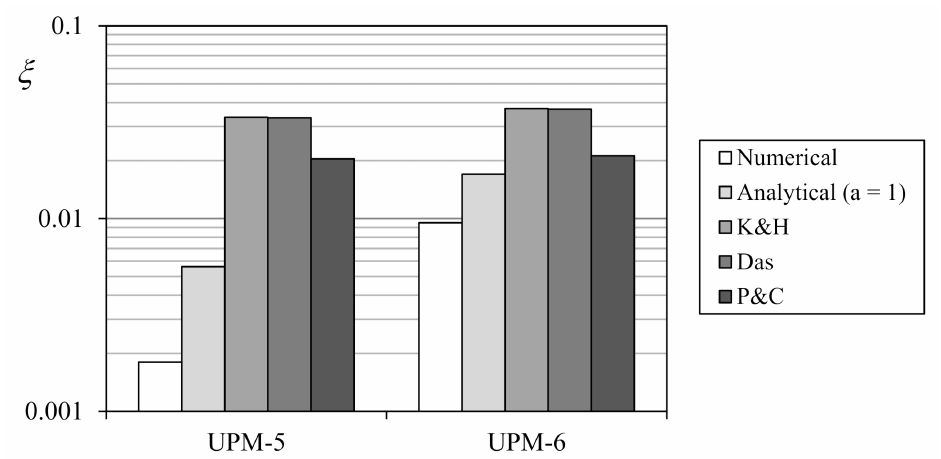
Figure 13. Non-dimensional RMSE, ξ , for the numerical fit of the 1-D/2-R equivalent circuit model, and the analytical fit with the proposed method, for the UPM-5 and UPM-6 solar panels of UPMSat-1. Values derived from the explicit methods studied here are also